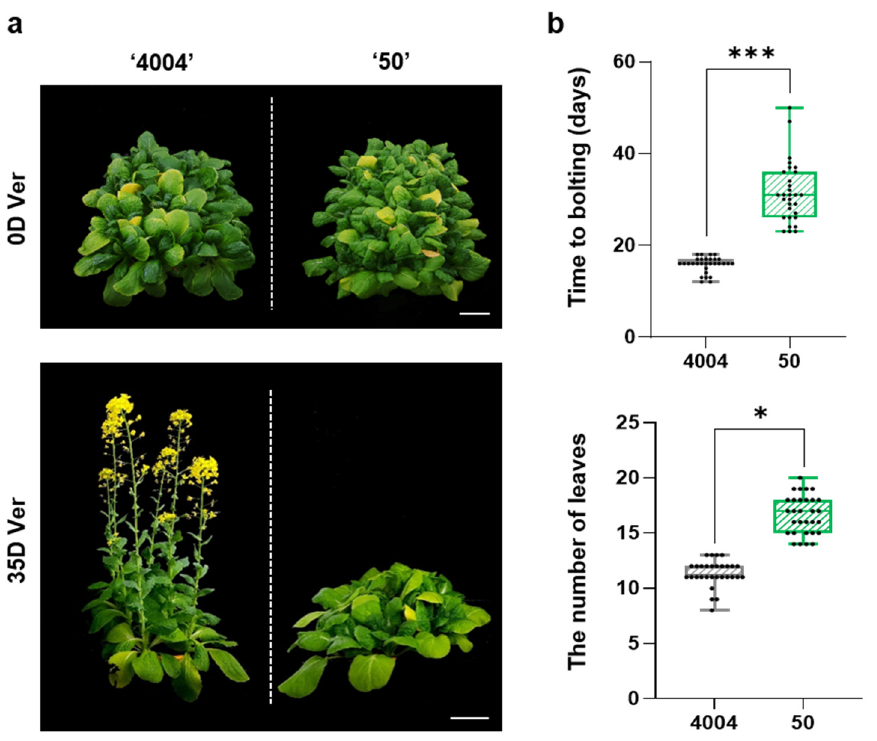
Figure 1. Extensive bolting variation in two Chinese cabbage inbred lines, “4004” and “50”, in response to vernalization. ( a ) Bolting phenotypes of the early-bolting line “4004” and the late-bolting line “50” following vernalization for 0 or 35 days. Non-vernalized seedlings (0 days, 0D Ver) were grown at 23 °C for 30 days. Vernalized seedlings (35 days, 35D Ver) were grown at 5 ± 1 °C and 12 h light/12 h dark photoperiod for 35 days and then transferred to a growth room at 23 °C for 20 days. Scale bar = 5 cm. ( b ) Statistical analysis of the days to bolting and the number of leaves in the two inbred lines. The leaves were counted when the plants started bolting. All experiments were performed in three independent biological replicates ( n = 10 per replicate). Statistically significant differences are indicated with asterisks (* p < 0.05, *** p < 0.001; Student’s t